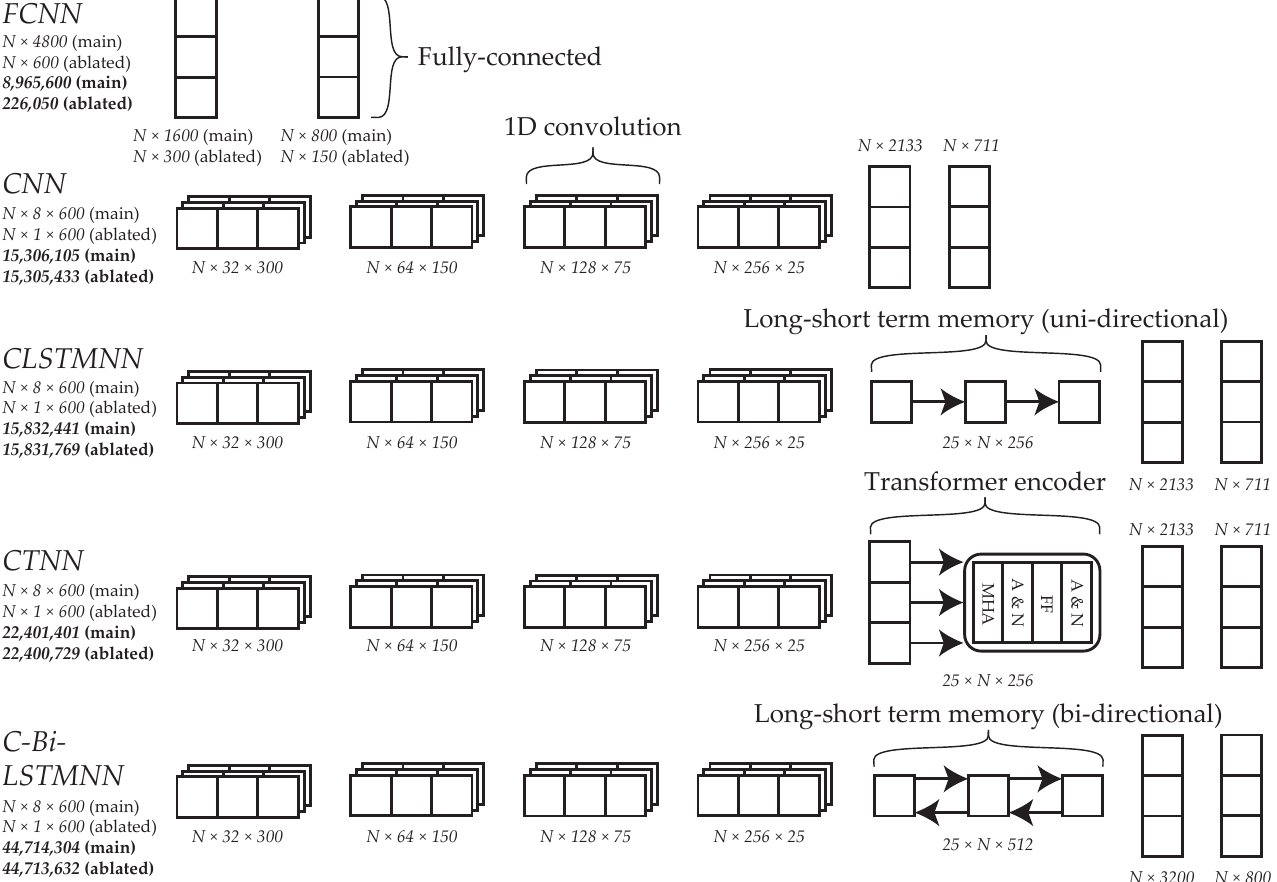
Figure 5. Overview of the DNN architectures used in this study. Shown on the left is the name of each architecture, the shape of its input, and its total number of parameters (top-to-bottom, respectively). The shape notation is number of samples N × number of features F for the fully connected neural network (FCNN) and number of samples N × number of channels C × sequence length L for the others. CNN = convolutional neural network, CLSTMNN = convolutional long short-term memory neural network, CTNN = convolutional transformer neural network, C-Bi-LSTMNN = convolutional bi-directional long short-term memory neural